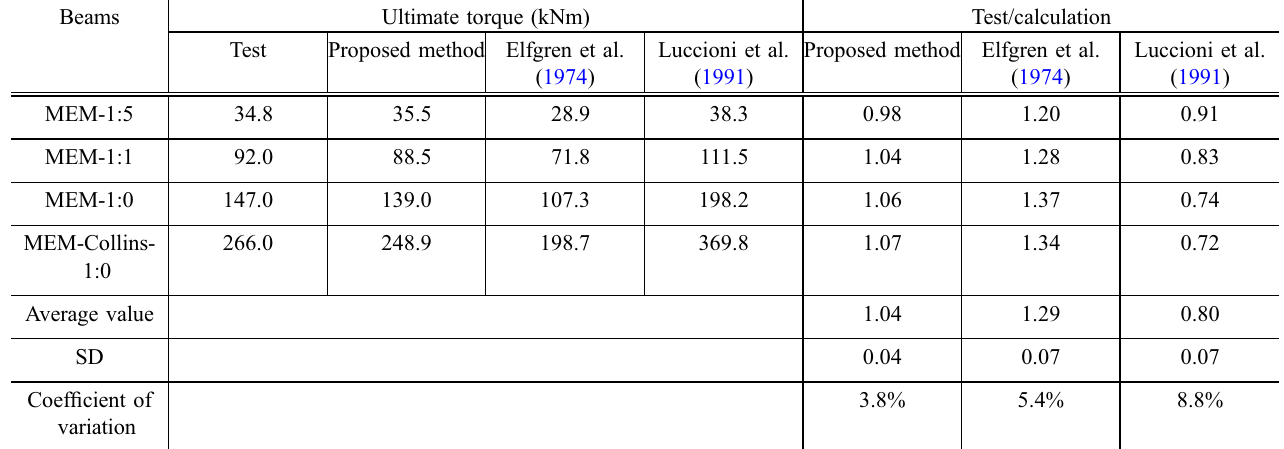
Table 5 Comparison of test ultimate torques and calculated ultimate torques. Beams Ultimate torque